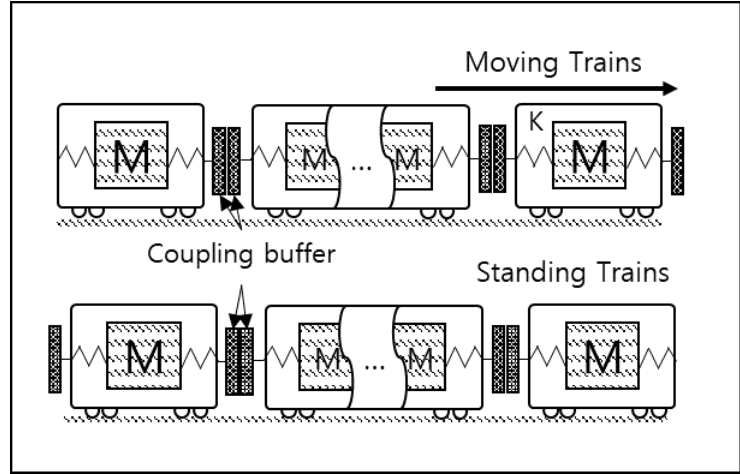
Figure 15. Collision system model.